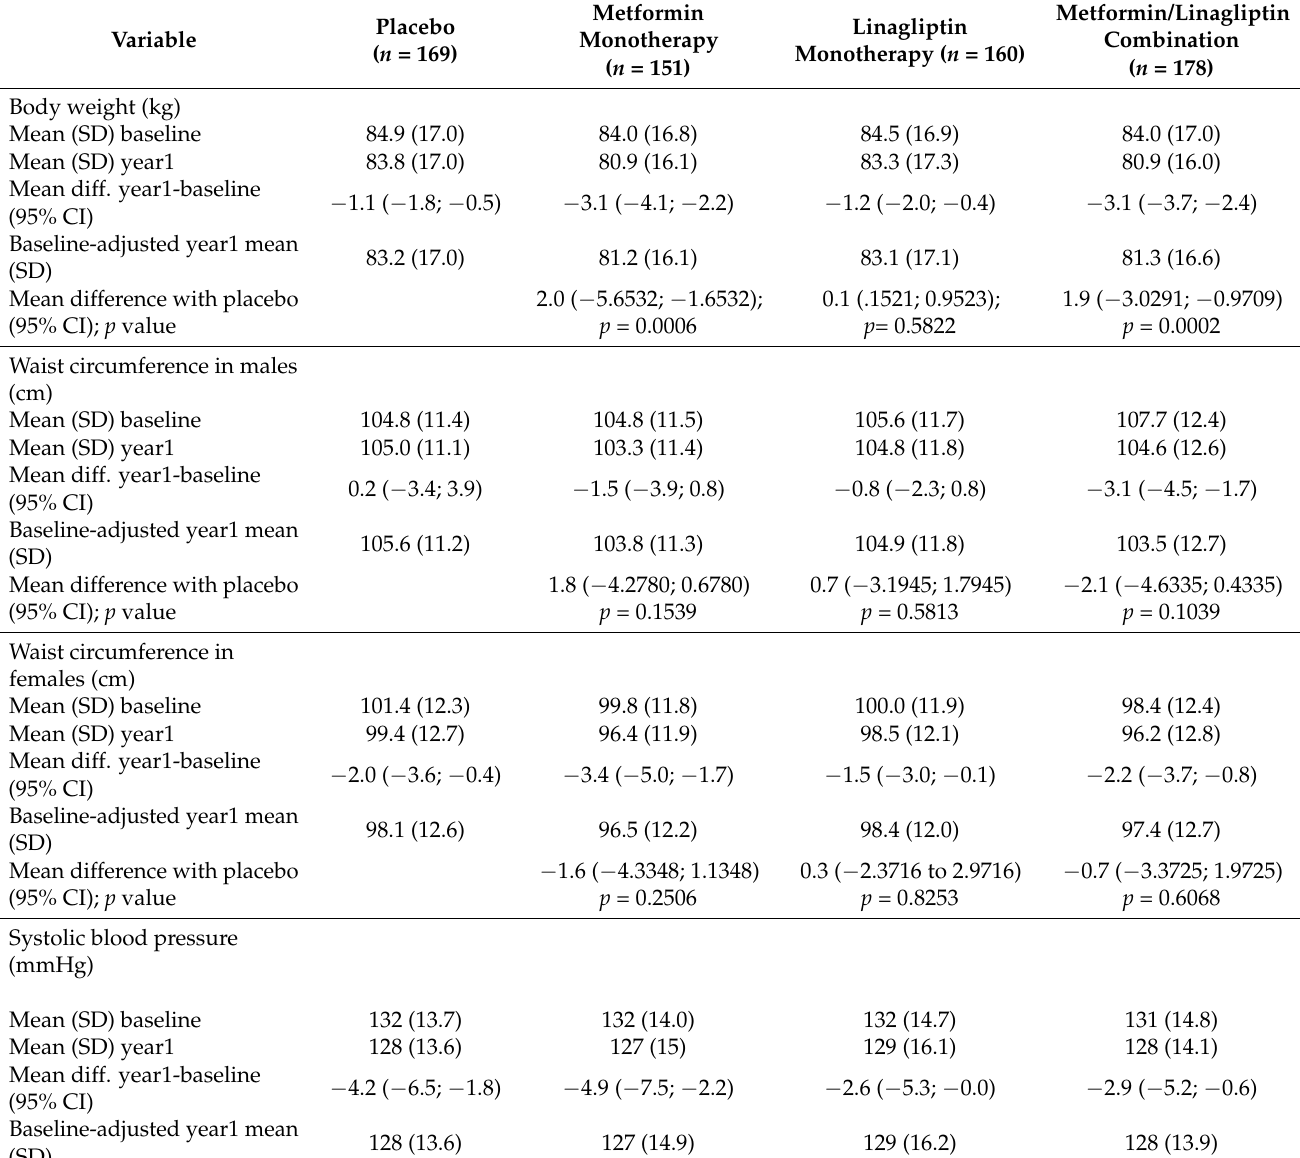
Table 2. Changes after 1-year treatment by study group and comparisons with placebo in participants who completed the 1-year follow-up examination ( n =